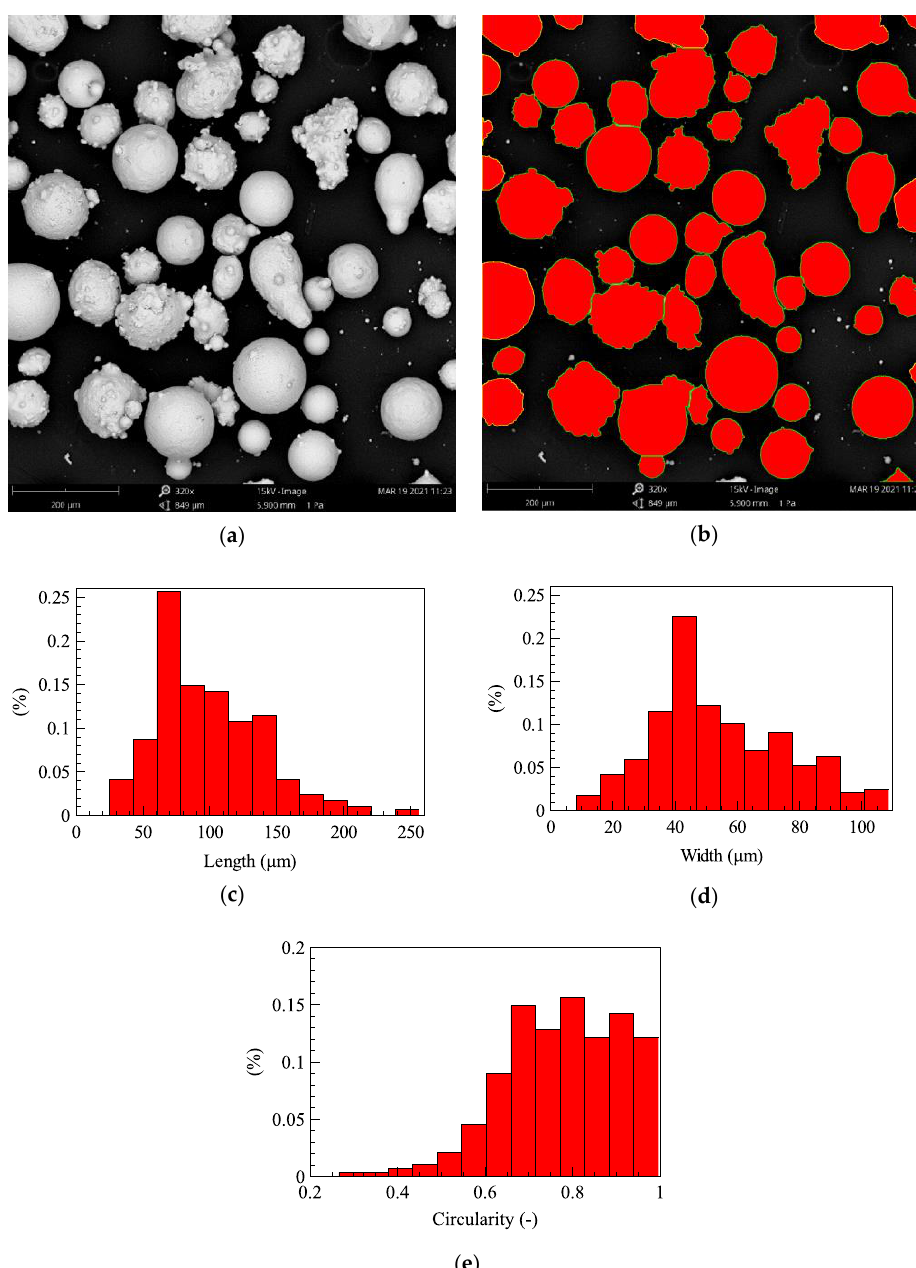
Figure 9. Size and shape characterization of 3D printing metal waste. ( a ) SEM image; ( b ) SEM image ready for characterization; ( c ) Histogram of particle length distribution; ( d ) Histogram of particle width distribution; ( e ) Histogram of particle circularity distribution.